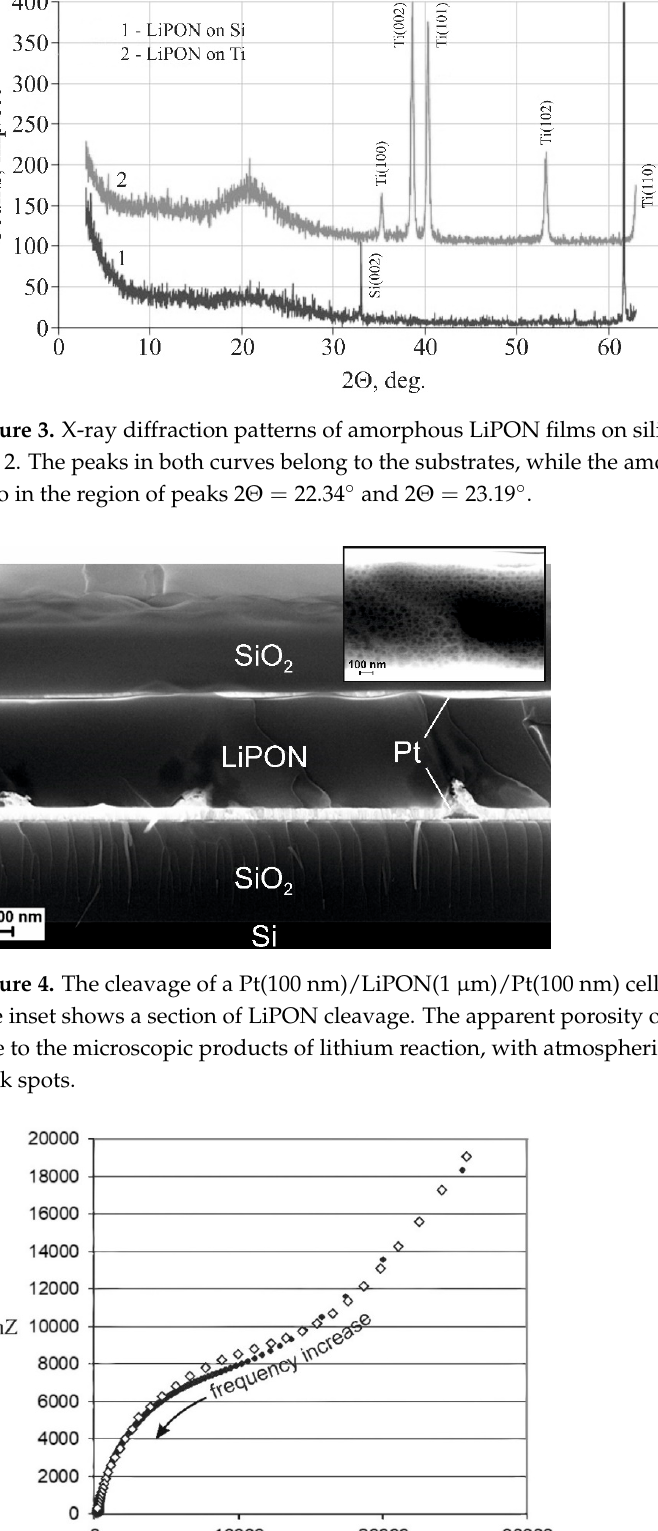
Figure 6. Structure of experimental cell Pt/LiPON/Pt: a —cell structure and direction of diffusion fluxes at constant voltage, and b —structural model of LiPON. In a simplified model (Figure 7), both EDLs were represented by one capacitor, 2 dl C / , and one leakage circuit. The current through the resistor, lk R , simulates the redox reactions at the electrodes, while its value is determined by the rate of these reactions. The leakage current circuit is closed through the Warburg element, W 2 , which simulates the resistance to the diffusion flux of lithium atoms moving from the cathode to the anode, where they are oxidized again.